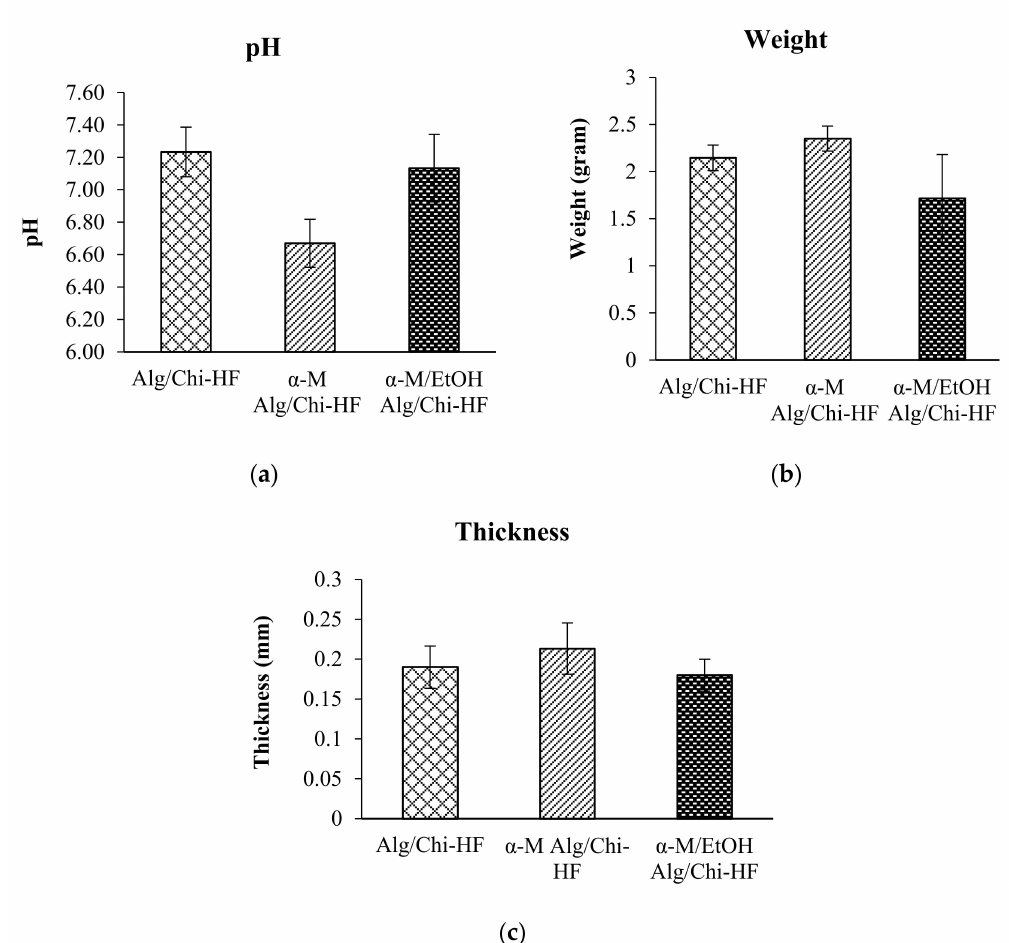
Figure 3. The thickness ( a ), weight ( b ), and pH ( c ) of Alg/Chi HF, α -M Alg/Chi HF, and α -M/EtOH Alg/Chi HF. The results are expressed as the mean ± SD ( n = 3).